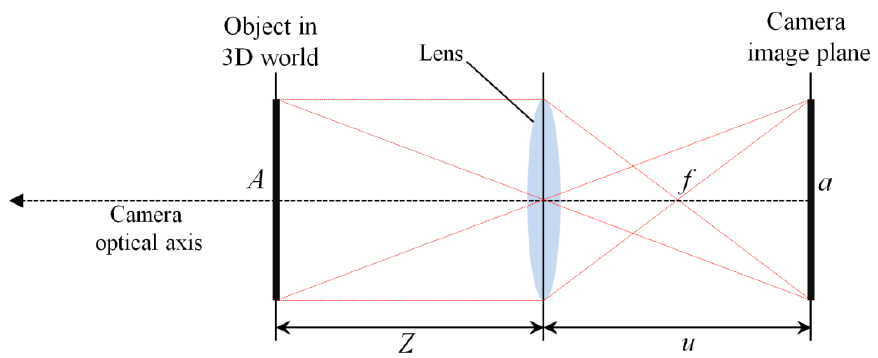
Figure 7. Camera optical